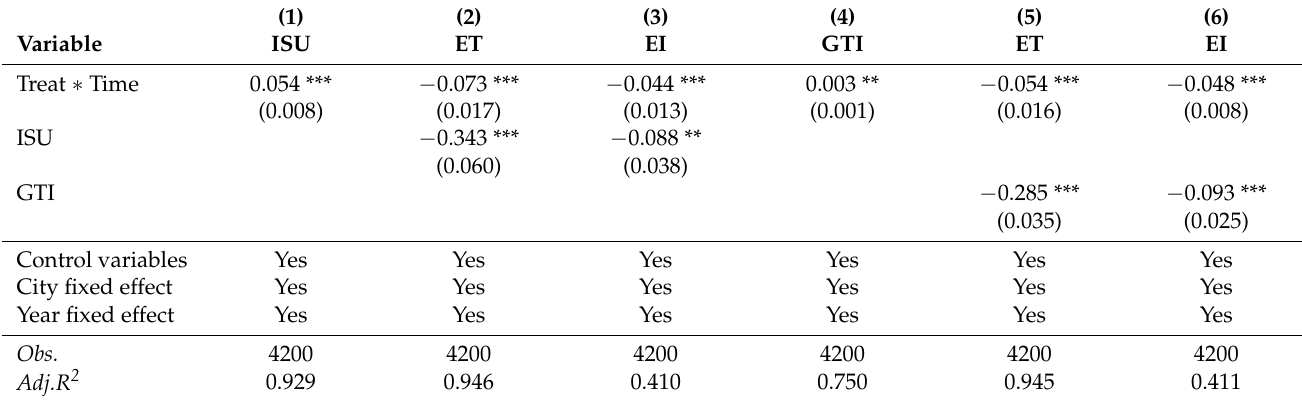
Table 6. Mechanism tests of energy quota trading on energy